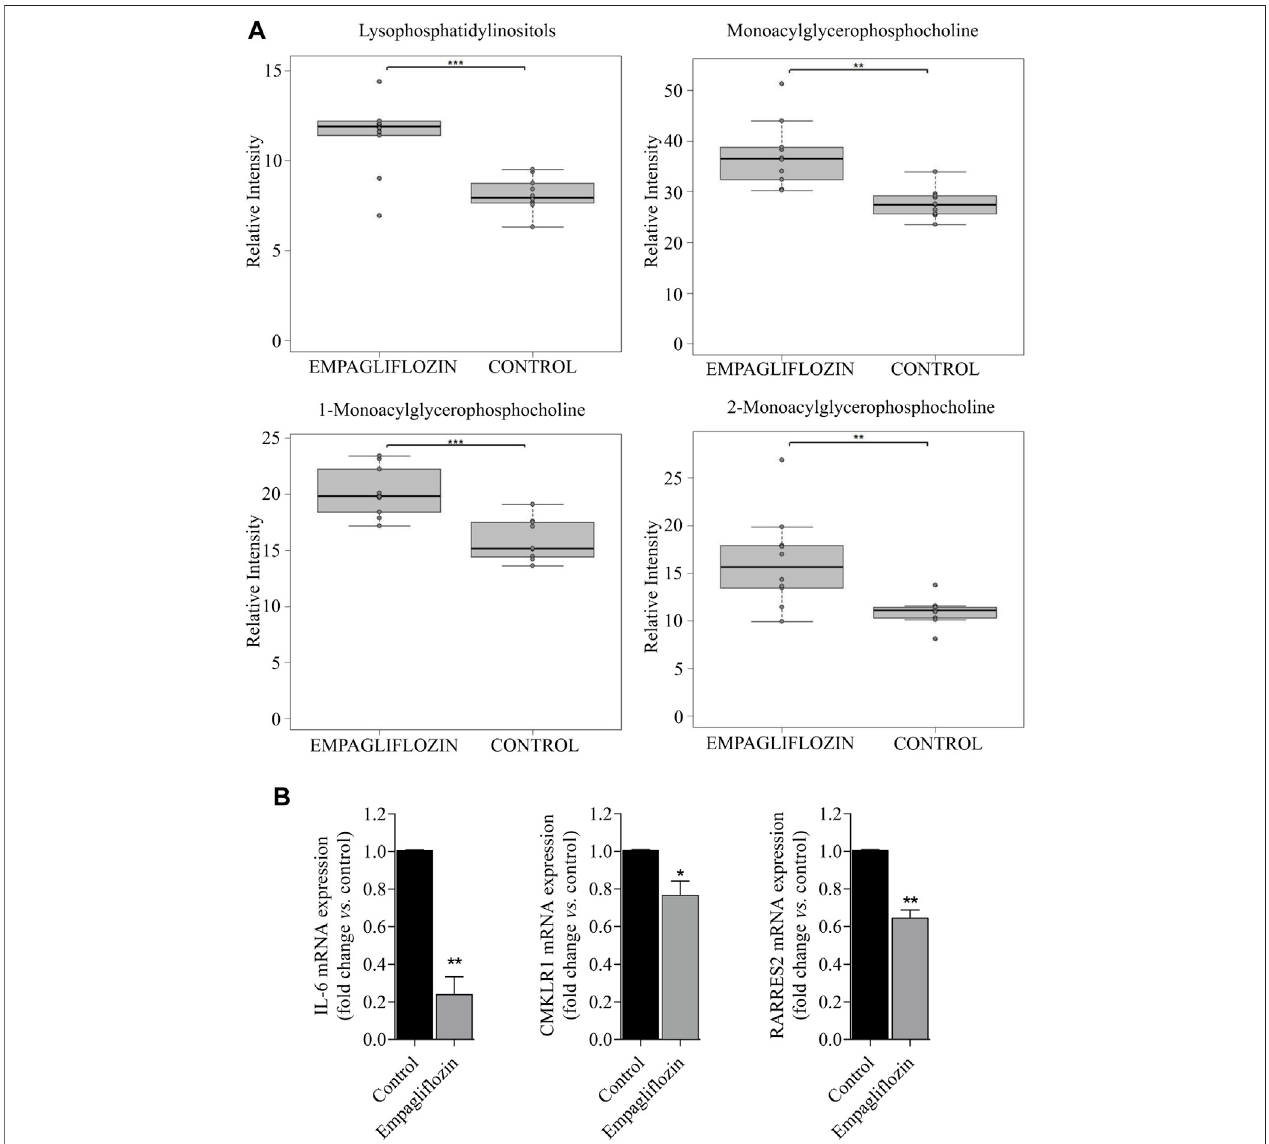
FIGURE 3 | Metabolic classes and pro-in fl ammatory markers altered in the liver by empagli fl ozin treatment. (A) : Boxplots of lysophospholipids for the comparison empagli fl ozin vs. control. (B) : Statistical analysis of RT-PCR for RARRES2 (chemerin),chemerin receptor (CMLKR1) and IL-6 in the liver of diabetic ZDF rats treated with empagli fl ozin vs. control. a.u: arbitrary units. * p < 0.05, ** p < 0.01, *** p < 0.001.